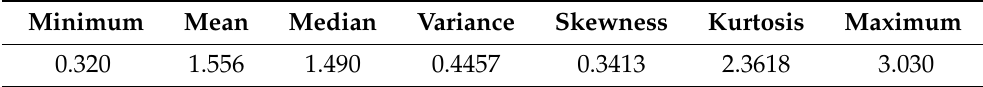
Table 7. Descriptive statistics of the carbon dioxide data